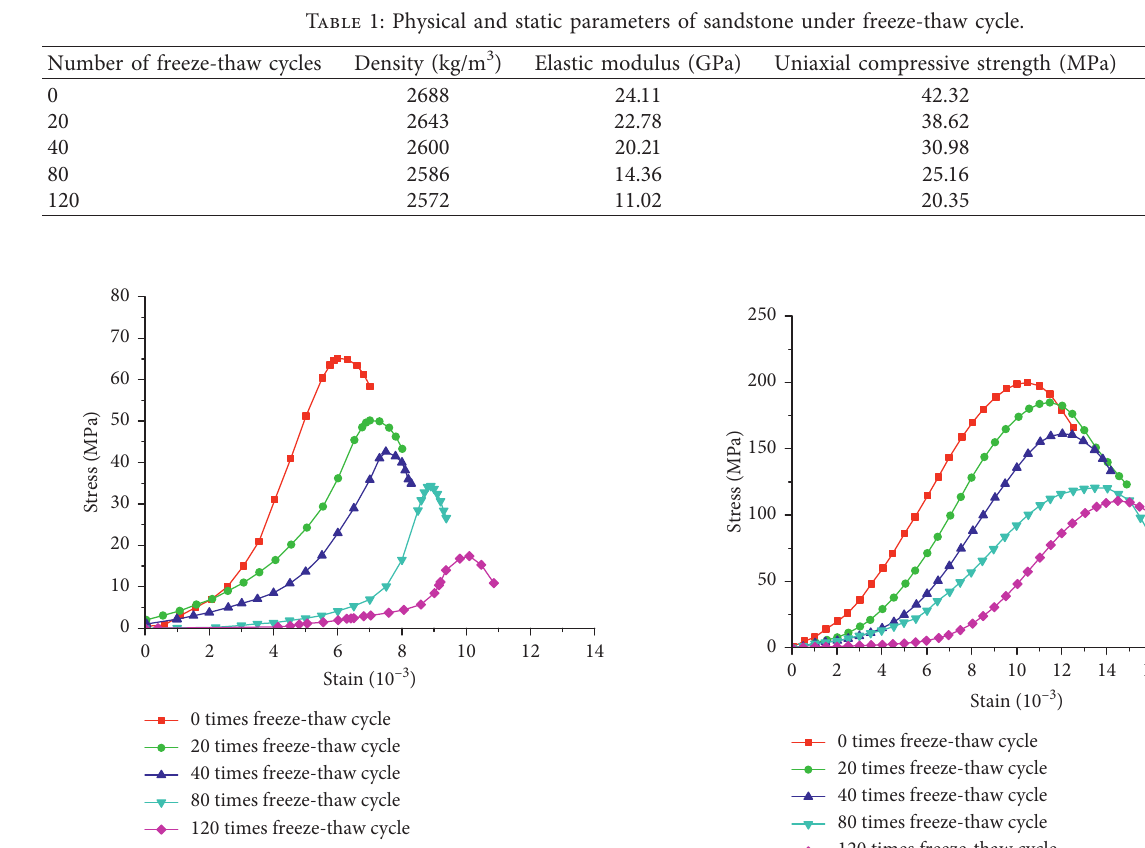
Figure 4: Stress-strain curves of sandstone in different freeze-thaw cycles under 0.04MPa impact pressure.